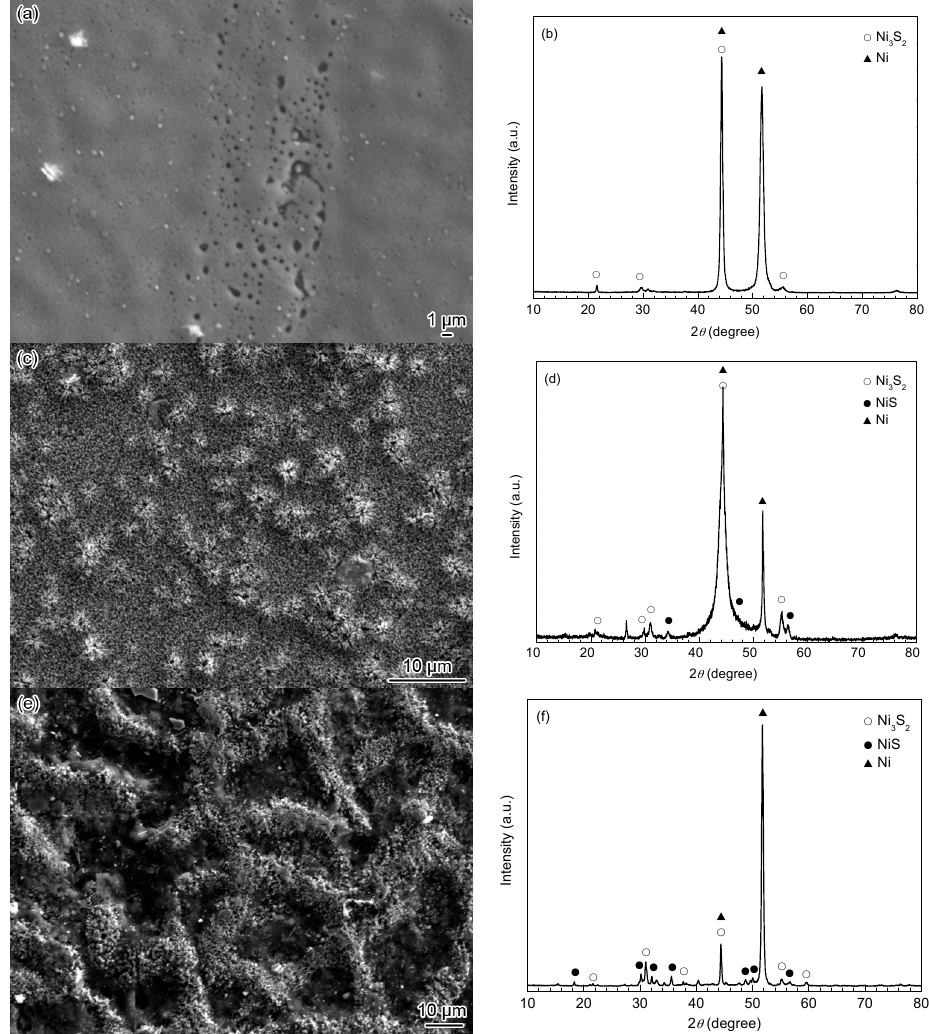
Figure 6. ( a , c , e ) SEM surface morphologies and ( b , d , f ) XRD spectra of corrosion scales on the Ni-based alloy coating exposed to the H 2 S/CO 2 environment for 168 h at different temperatures: ( a , b ) 60 °C; ( c , d ) 90 °C and ( e , f ) 140 °C.